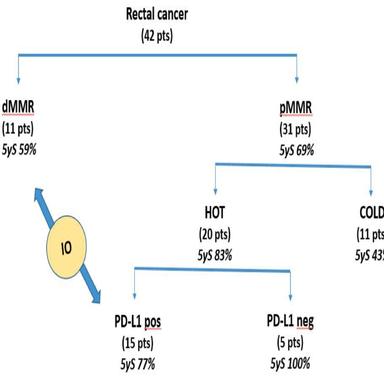
Stratification of 42 rectal cancer cases analyzed in the study, according to MMR status (d: deficient, p: proficient), immunological fertility (hot vs. cold) and PD-L1 status (positive vs. negative), and prognostic relevance (5-year survival). Subgroups of patients postulated to benefit from PD-1/PD-L1 immunotherapy (IO) are indicated.